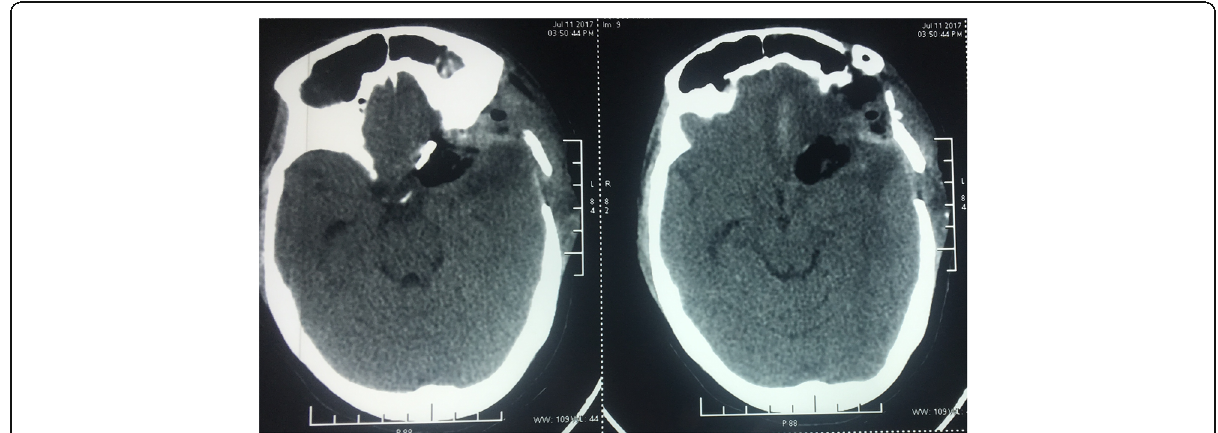
Fig. 4 Showing the drilled clinoid and optic roof on the left